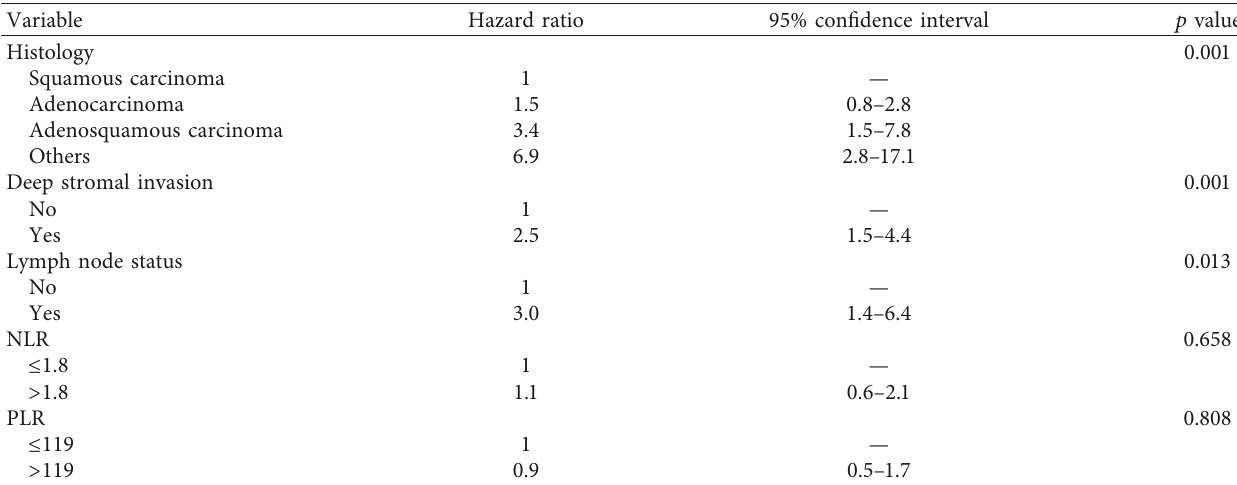
Figure 2: The overall survival according to neutrophil/lymphocyte ratio (a) and platelet/lymphocyte ratio (b). Table 4: Multivariate analysis of disease-free